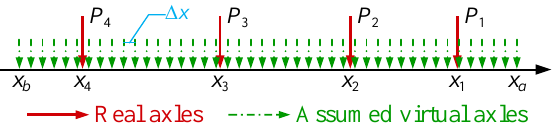
Figure 2. Example of real and virtual axles.